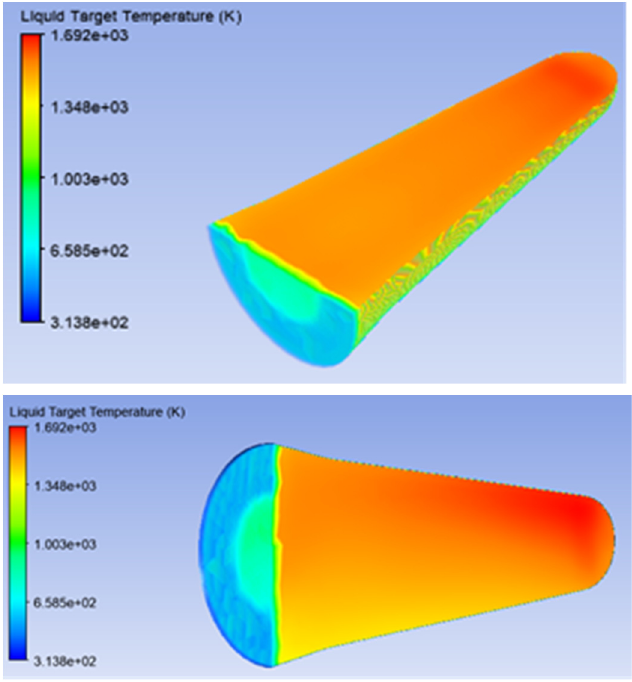
Figure 6. Temperature of the liquid target in horizontal ( top ) and vertical ( bottom ) cuts.